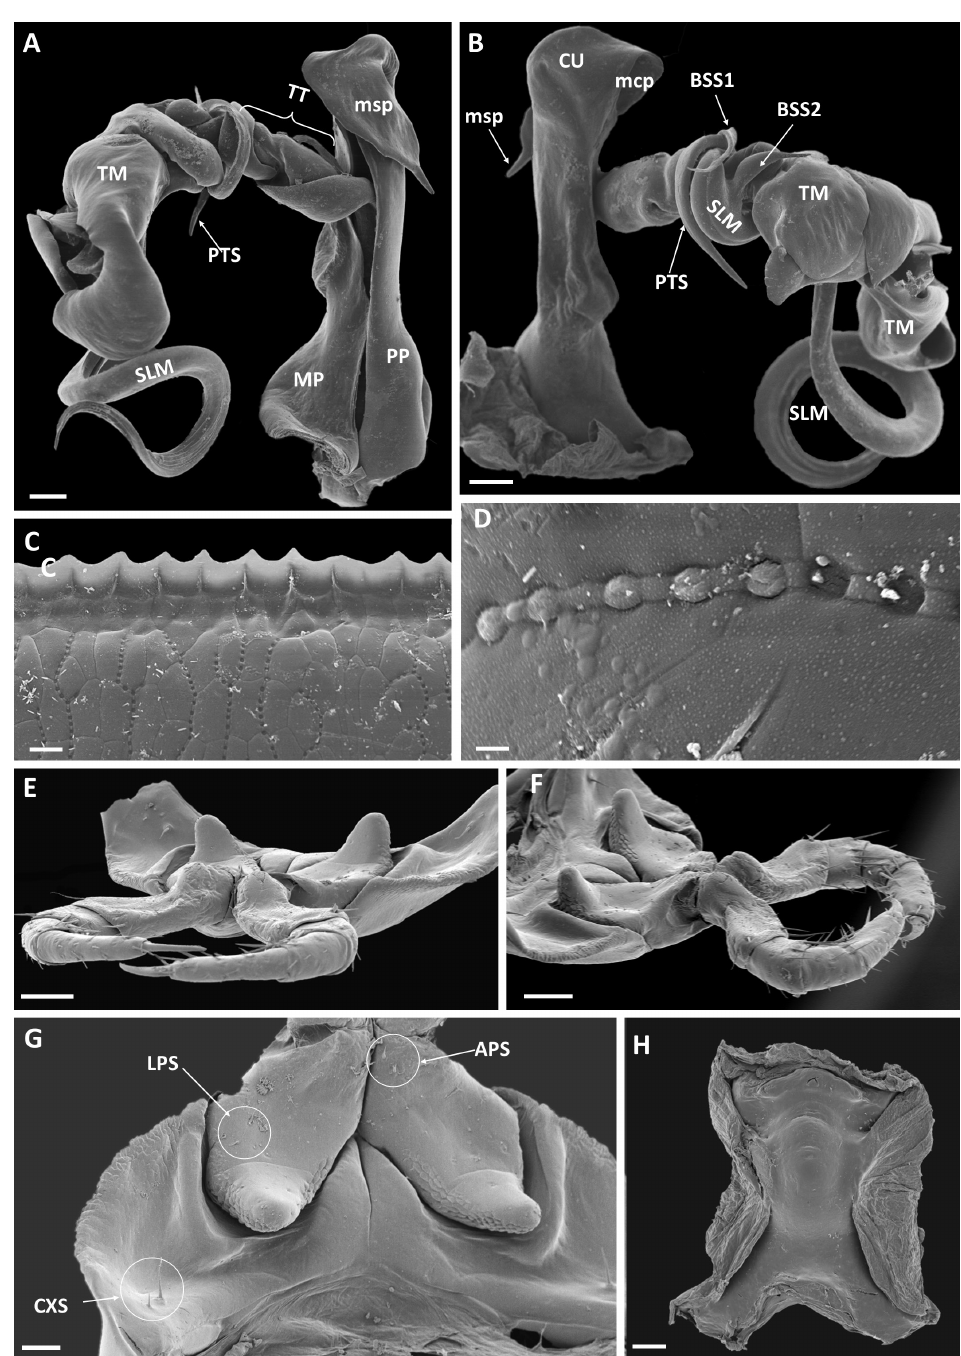
Fig. 58. Syndesmogenus voiensis (Ribaut, 1907). A–G . Specimen from E Usambara Mts (NHMD 621763). A. Right gonopod, anterior view. B. Right gonopod, posterior view. C. Midbody dorsal limbus, notice interscutal structures. D. Interscutal structures (fungi?) with spherical bodies to the left in the picture and ?sockets after such structures to the right. E–G . First pair of legs. E. Ventral view. F. Sublateral view. G. Anterior view. H . Specimen from Mt. Kilimanjaro (NHMD 621764), sternum 9. Abbreviations: APS = mesapical prefemoral setae; BSS1 , BSS2 = basal solenomeral spines; CU = cucullus; CXS = coxosternal setae; LPS = lateral prefemoral setae; mcp = mesal cucullar process; MP = metaplica; msp = metaplical spinelike process; PP = proplica; PTS = post-torsal spine; SLM = solenomere. Scale bars: A–B, E–F = 0.1 mm; C = 0.01 mm; D = 0.001 mm; G–H = 0.05